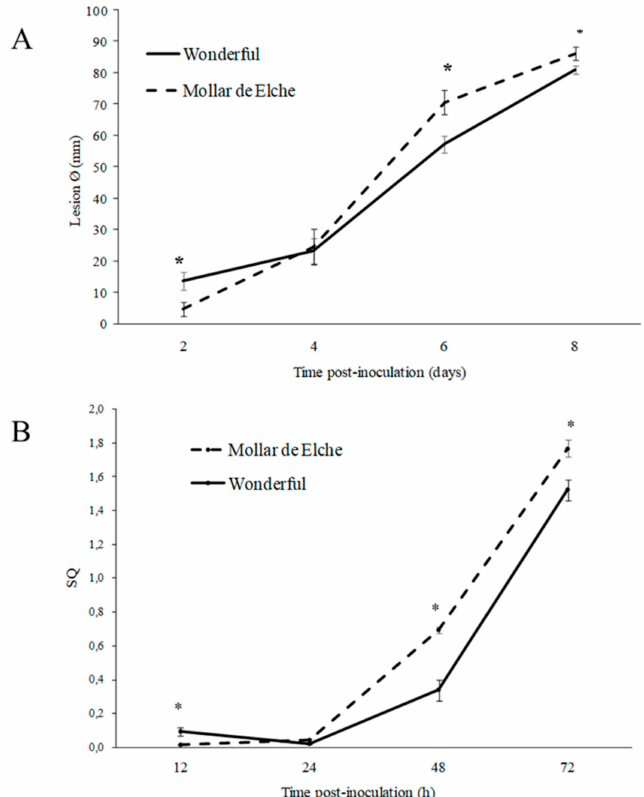
Figure 1. Growth curve of P. granati artificial inoculum on the two pomegranate cultivars Wonderful and Mollar de Elche: ( A ) lesion Ø (mm) at 2–8 days post-inoculation; ( B ) SQ of pathogen DNA in qPCR reaction, coming from inoculated fruit sampled at 12–72 h post-inoculation. Data represent the mean of three values ± standard error of mean (SEM). Time points with an asterisk are statistically di ff erent according to Duncan’s Multiple Range Test (DMRT, * p <